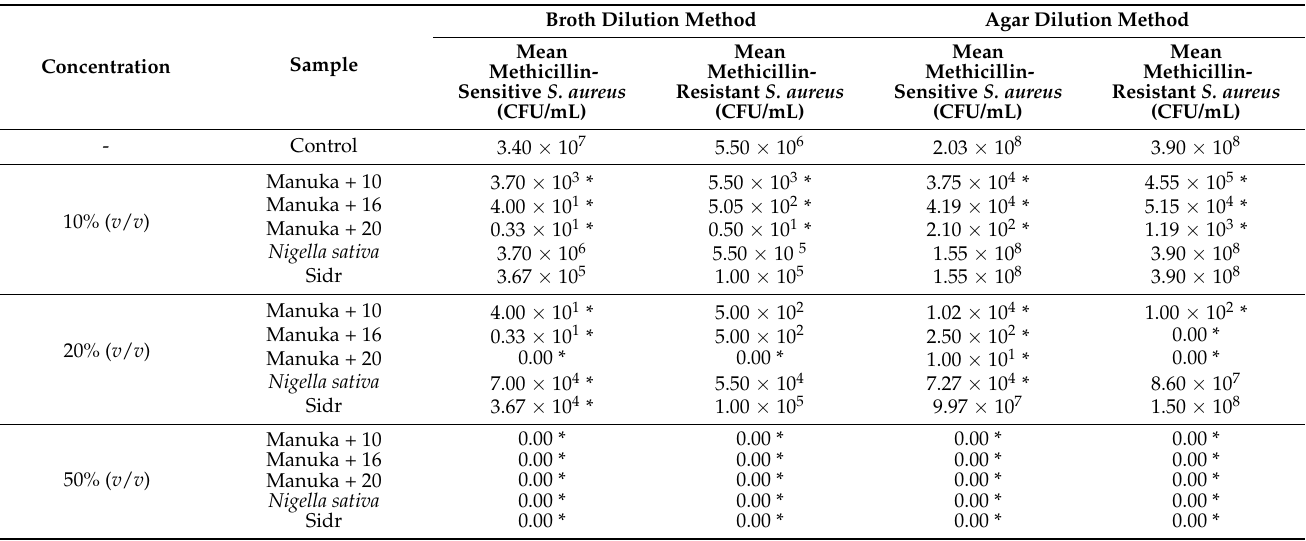
Table 2. Comparison of the effects of different types and concentrations of honey on S. aureus . Reprinted with permission from ref. [115]. Copyright 2017 Elsevier